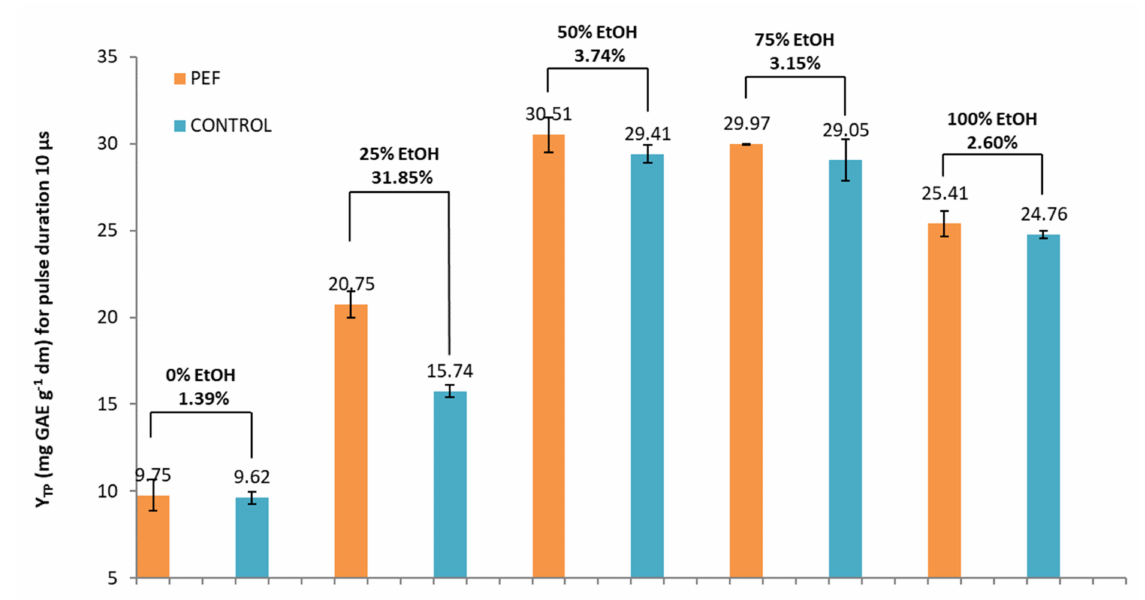
Figure 3. Y TP (mg of gallic acid equivalents (GAE) per gram of dry weight (dw)) for PEF and control samples in five different tested solvents and a pulse duration of 10 µ s.